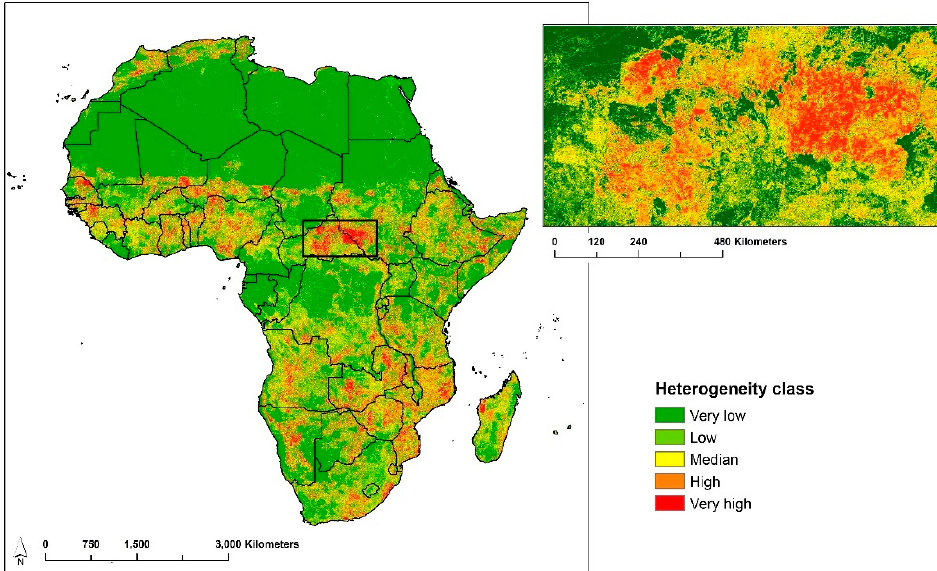
Figure 7. LCCI distribution for Africa. The map shows the high heterogeneity regions for grass-shrub and forest mosaic land covers in Central Africa.